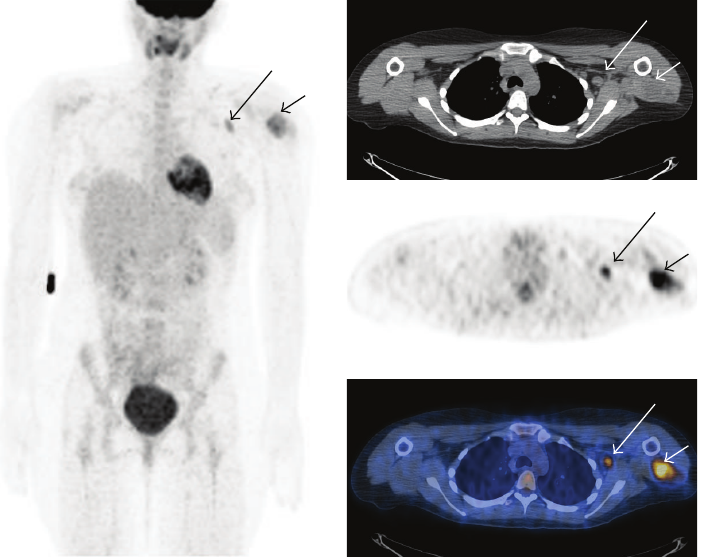
Figure 2: False Positive a 29 year old with an angiomatoid malignant histiocytoma of the left deltoid (short arrow) with an SUV of 6.5. The FDG-PET scan demonstrated a hypermetabolic left axillary lymph node (long arrow) with an SUV of 4.4. The latter was biopsied and was a reactive lymph node on final